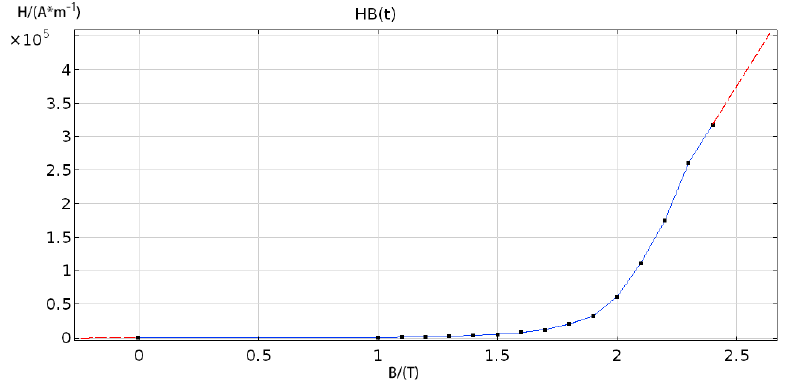
Figure 8. H–B curve.